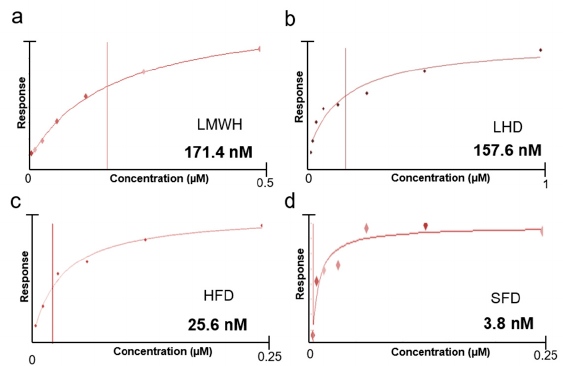
Figure 3. Relative surface plasmon resonance (SPR) responses for ( a ) low molecular weight heparin (LMWH), ( b ) low molecular weight heparin and DOCA conjugate (LHD), ( c ) heparin fragment and DOCA conjugate (HFD), and ( d ) SFD in HEPES (hydroxyethyl piperazineethanesulfonic acid)-buffered solution immobilized with VEGF on a CM5 chip. The affinity curves were plotted by using the Biacore T100 evaluation software.